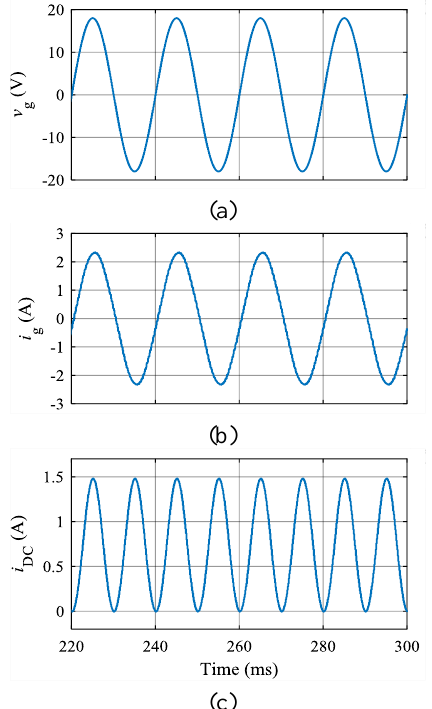
Figure 13. With ϕ 1 = π /2, θ = π /2, ( a ) the AC side voltage v g ; ( b ) AC side current i g ; and ( c ) DC side current i DC without the DC side power decoupling.